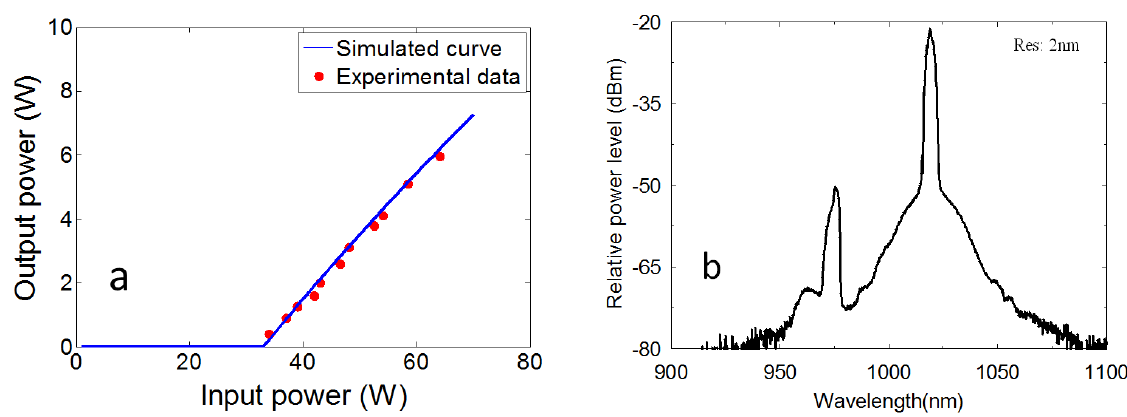
Figure 7. ( a ) Experimental FRL output power with DCRF vs. pump power; ( b ) Experimental FRL output spectrum at 6 W maximum powers with